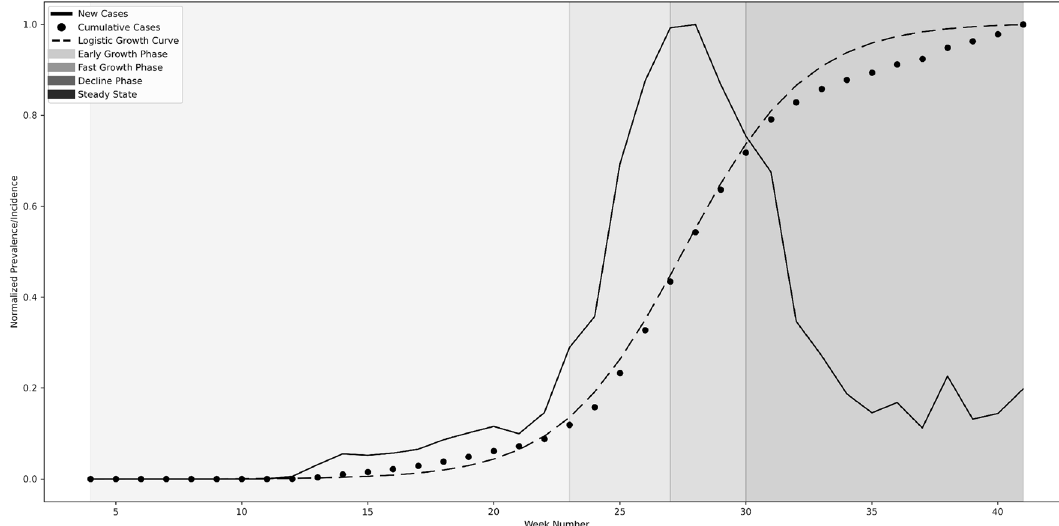
Figure 2. Logistic growth model applied to the state of Arizona.